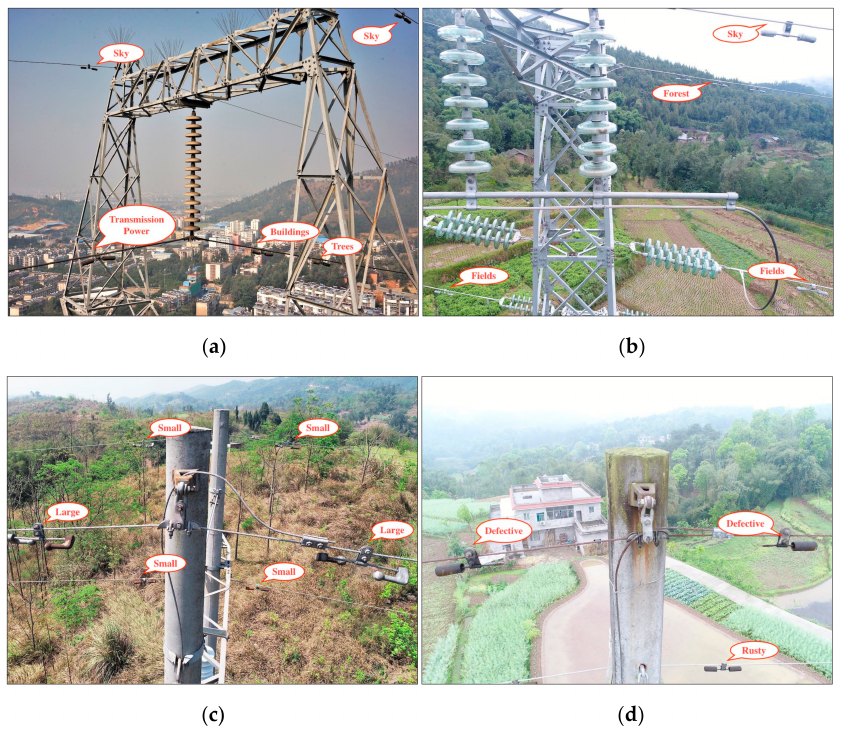
Figure 5. Different background contexts, sizes, and classes of vibration dampers in images: ( a ) and ( b ) containing sky, buildings, transmission towers, and trees; ( c ) containing small and large objects; ( d ) containing two classes of vibration dampers: “defective” and